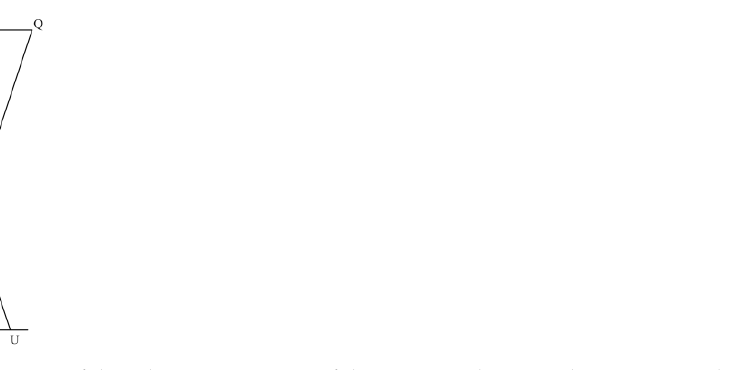
Figure 8. Top view of the schematic position of the camera relative to the opposite pole tower. Top view of the tree-line scene and the imaging